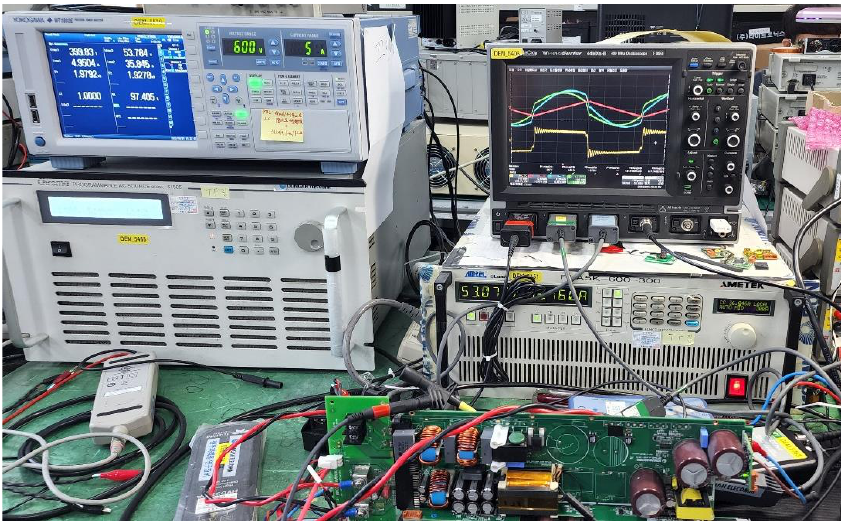
Figure 17. Experimental circuit and experimental configuration.